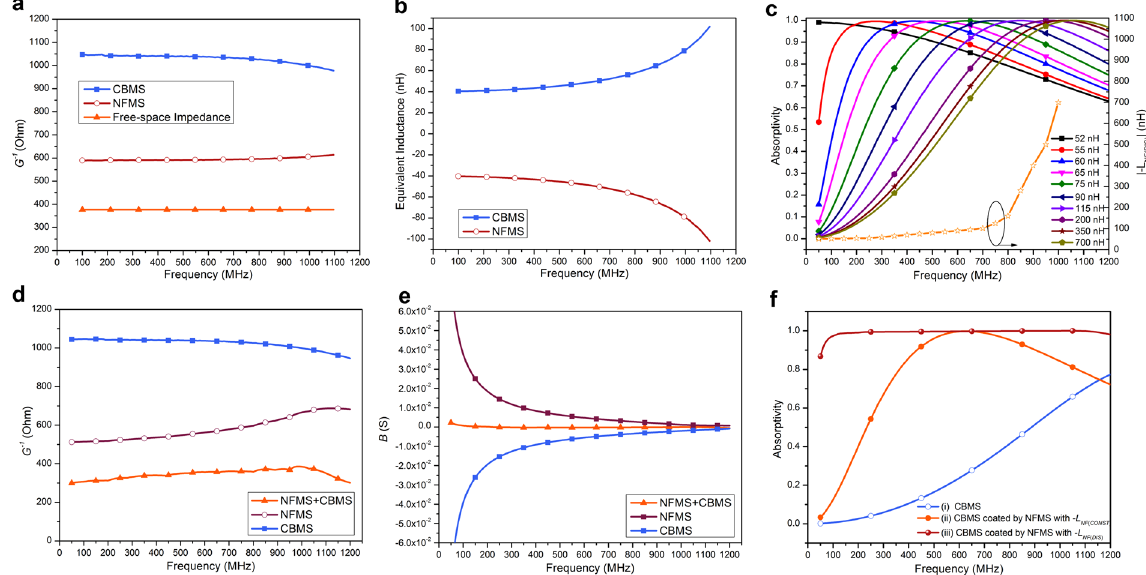
Figure 2. Theoretical calculation and full-wave EM simulation. ( a , b ) Calculated G and L of the CBMS and NFMS, according to equations (2) and (3). ( c ) Full-wave simulated absorptivity of the NFMS with different [ − L NF(CONST) ] and the translated frequency-dispersive [ − L NF(DIS) ] for perfect absorption (right y-axis). ( d , e ) Full- wave simulated conductance G and susceptance B of the CBMS, NFMS and NFMS magnetic absorber, based on the non-Foster element with R NF ||[ − L NF ( DIS ) ]. ( f ) Full-wave simulated absorptivity of the following three cases: 1. CBMS only, 2. CBMS coated by NFMS with constant R NF ||[ − L NF(CONST) ] = − 75 nH, and 3. CBMS coated